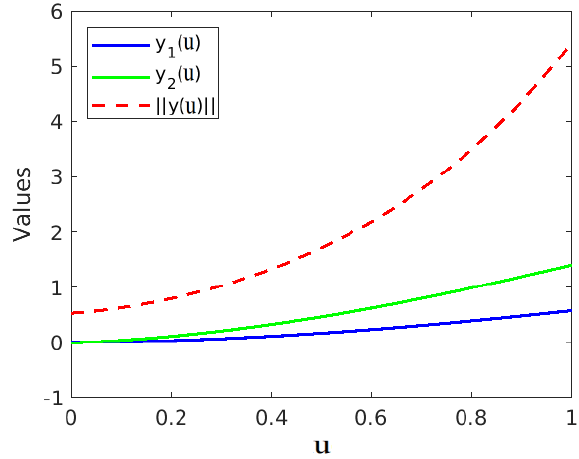
Figure 1. The state y ( u ) and || y ( u ) || of (22) Table 1. Finite-time stability results of (22) and fixed the time L =